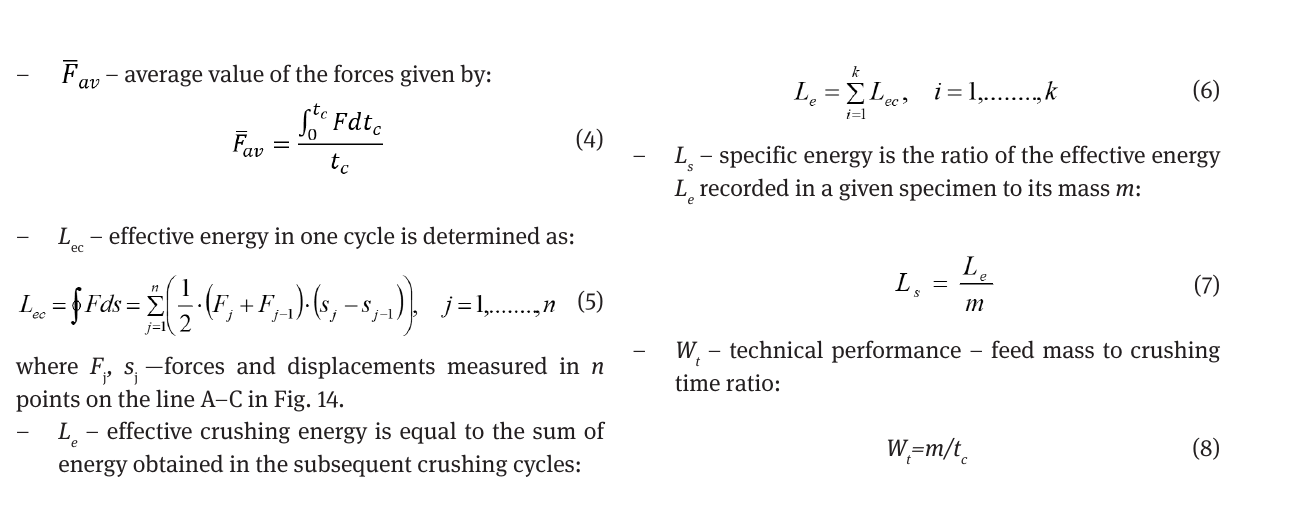
Figure 12: Plates used in the laboratory tests: a) flat, b, c) triangular profile, d, e) variable pitch and height of the teeth, f) variable width and pitch of the teeth (Fig.